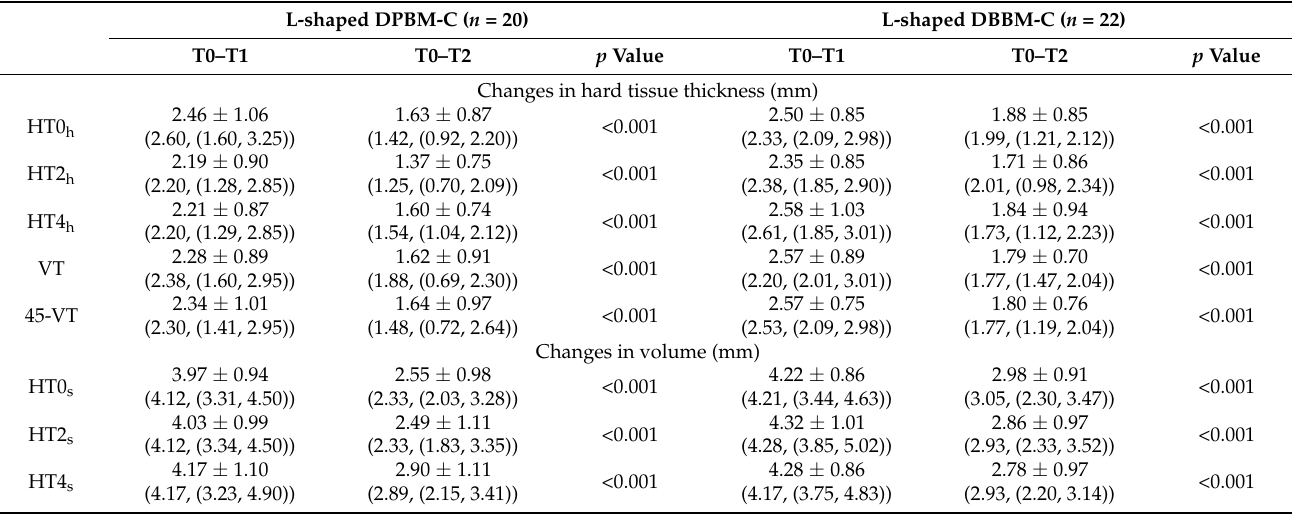
Table 2. Changes in hard and soft tissue thickness outcomes of the augmented site after GBR treatment of peri-implant dehiscence